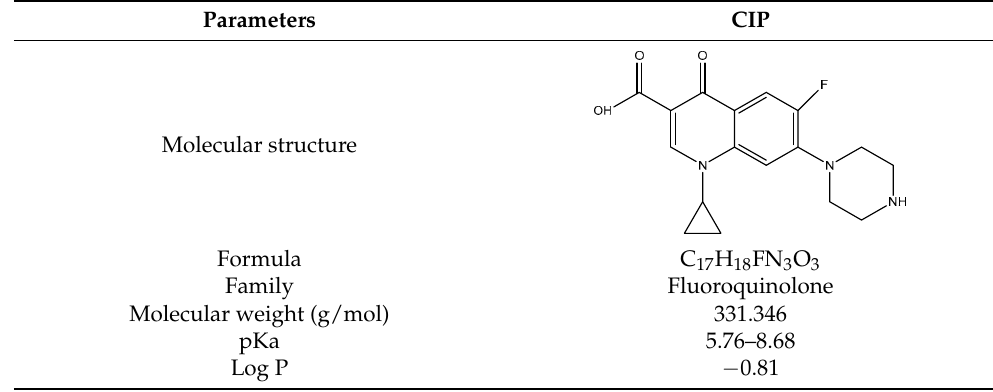
Table 1. CIP physical composition and chemical structure [21]. Parameters